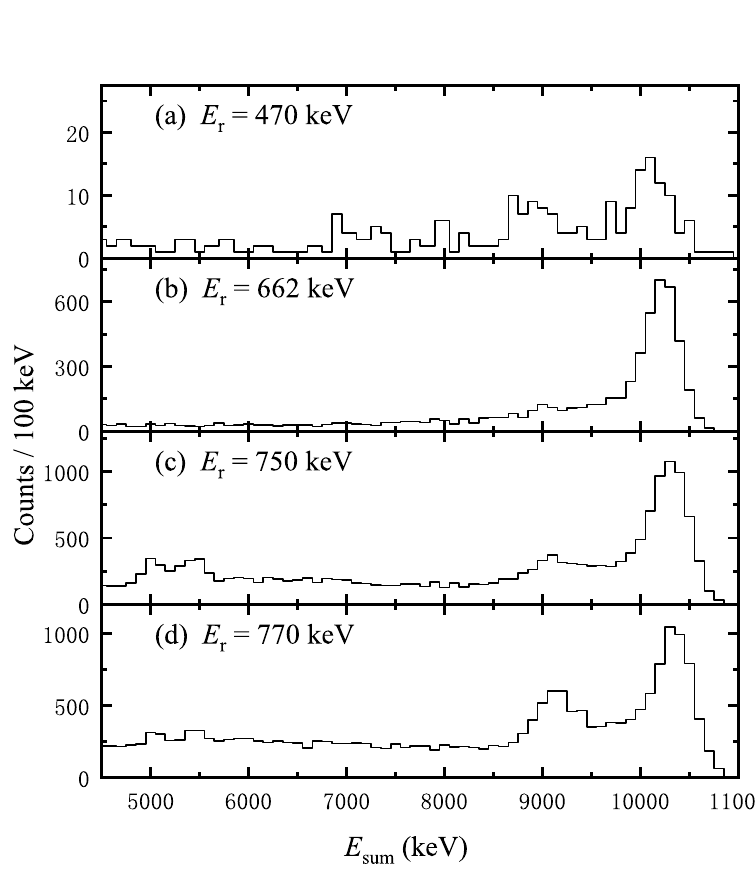
Figure 2: The sum spectra of the 18 O( α, γ ) 22 Ne resonances: (a) at E r = 470 keV, (b) at E r = 662 keV, (c) at E r = 750 keV, (d) at E r = 770 keV, respectively.